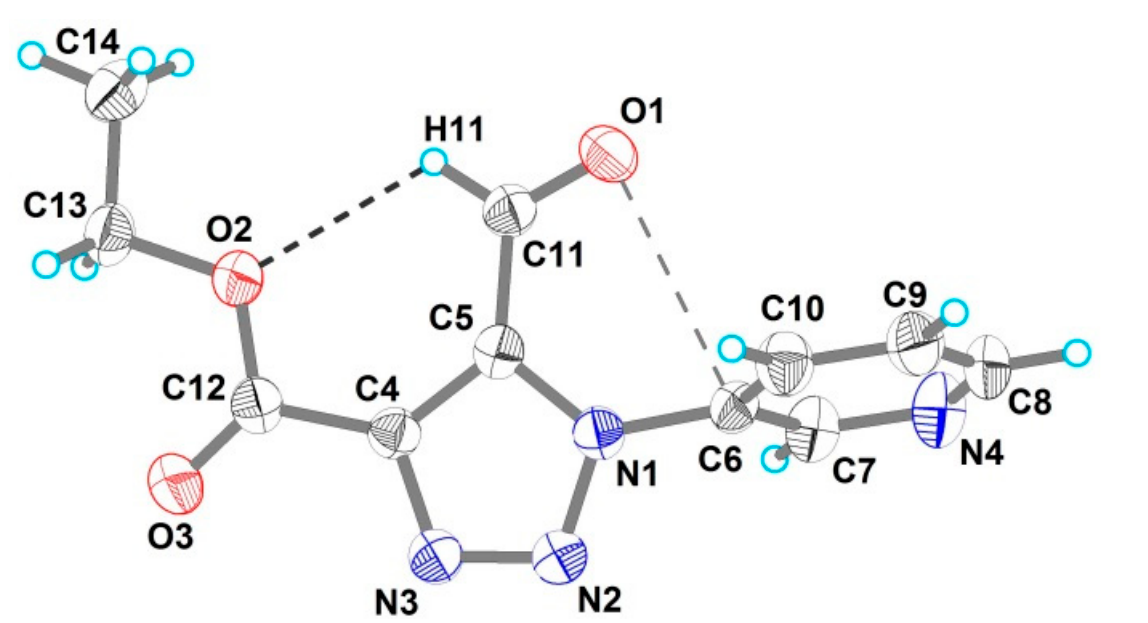
Figure 1. The molecular structure of 4 (derived from a single-crystal XRD experiment) with dis- placement ellipsoids drawn at the 50% probability level. Intramolecular hydrogen bond and n → π * interaction are shown as dashed lines. Table 1. Selected bond lengths (Å) and angle values (°) in the structure of 4.